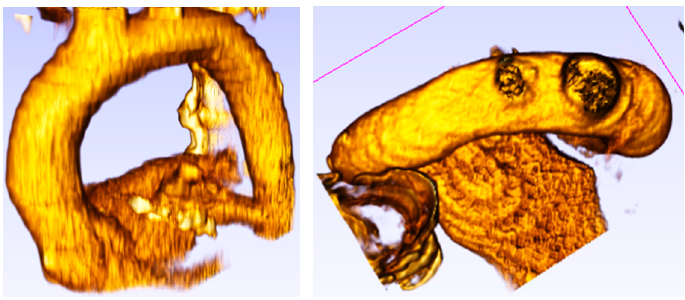
Figure 5. Healthy patient (pilot) (62 years old) without aorta disease.